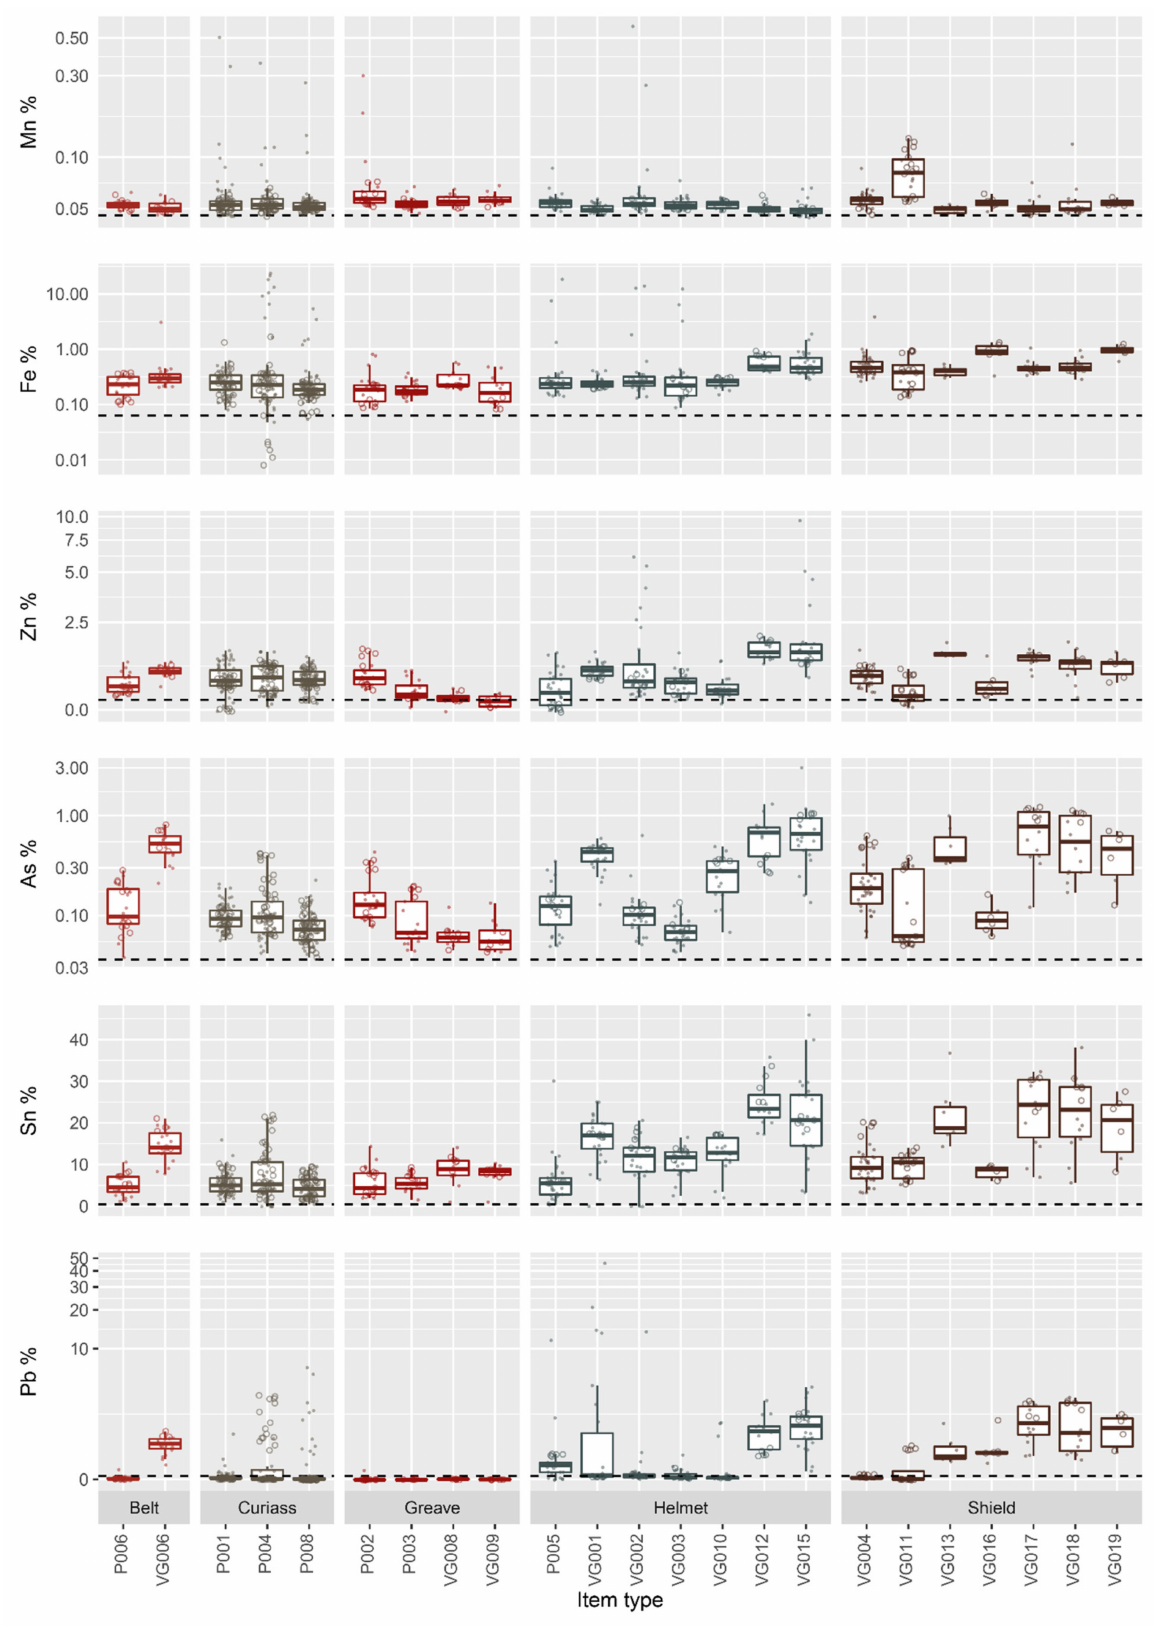
Figure 7. Box-plots of elements organised by type. Dashed lines indicate the limits of